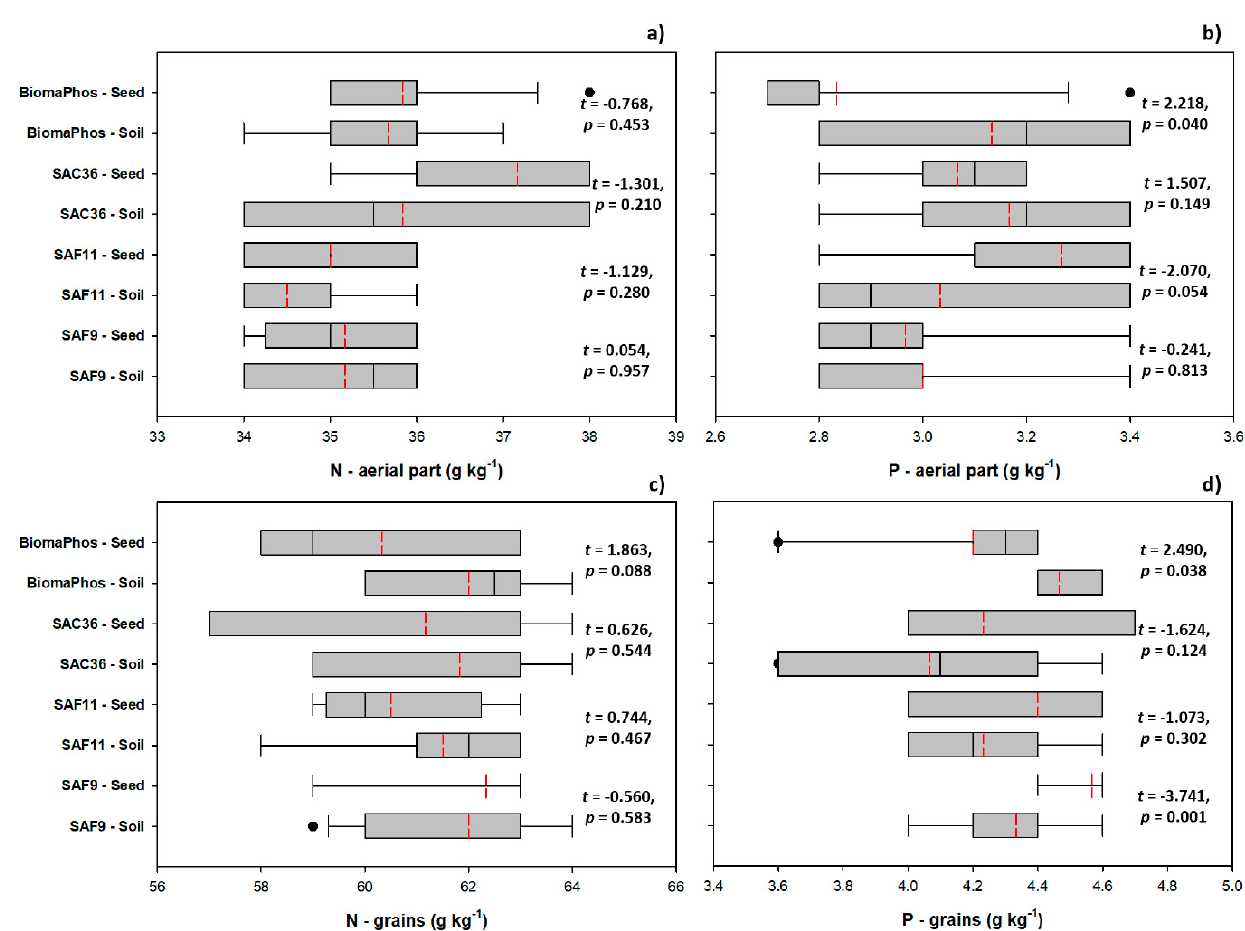
Figure 4. Effect of inoculation methods (via soil or seed treatment) of plant-growth-promoting rhizobacteria on the levels of N in the plant aerial part ( a ) and in the grains ( b ) and P in the aerial part ( c ) and in the grains ( d ) of Glycine max L. plants grown in summer 2019/2020 and 2020/2021, in five experimental fields of soybean cultivation in the interior of the state of Goiás, Brazil. SAF9, Brevibacillus sp.; SAF11, Brevibacillus sp.; SAC36, Bacillus velezensis ; BiomaPhos, Bacillus subtilis CNPMS B2084 (BRM034840) and Bacillus megaterium CNPMS B119 (BRM033112). The thousand-grain mass was affected by the inoculation method in plants treated with all tested strains, except SAF9. Mean values of 164.00 g and 173.00 g were observed for in- oculation via soil and seed, respectively, in plants treated with SAF11; 167.46 g and 179.70 g, respectively, in those treated with SAC36; and 169.00 g and 184.00 g, respectively, in those method (Figure 5a). Productivity, however, was only affected by the inoculation method in plants treated with SAC36 (4187.99 kg ha − 1 and 4629.80 kg ha − 1 , seed and soil inoculation, respectively) and BiomaPhos (4181.12 kg ha − 1 and 5035.47 kg ha − 1 , seed and soil inocula- tion, respectively); thus, higher mean values were observed in plants with inoculation via seed (Figure 5b). Mean MBC values of 99.73 mg kg − 1 and 229.14 mg kg − 1 were observed for soil and seed inoculation, respectively, in plants treated with SAF11; 153.49 mg kg − 1 and 226.29 mg kg − 1 , respectively, in those treated with SAC36; and 116.55 mg kg − 1